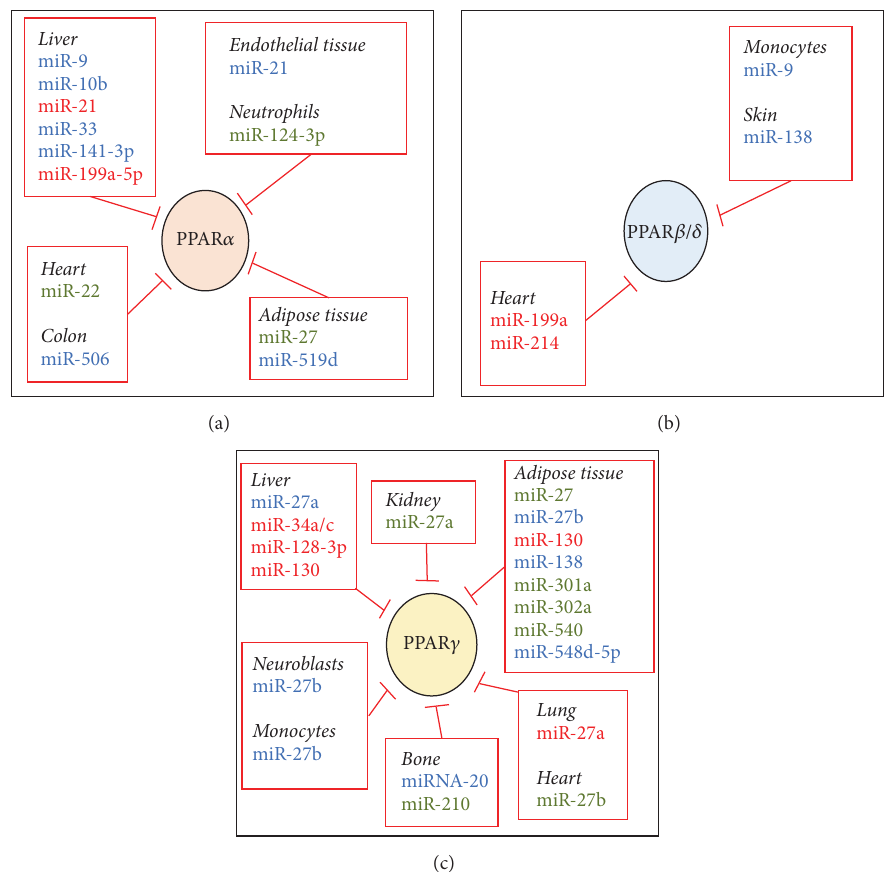
Figure 2: miRNAs targeting PPAR isoforms in specific tissues. miRNAs (also referred to in Table 1) that have been experimentally demonstrated to specifically target PPAR 𝛼 (Panel (a)), PPAR 𝛽 / 𝛿 (Panel (b)), and PPAR 𝛾 (Panel (c)) in different tissues are illustrated. miRNAs identified in human studies are in blue, those identified in mouse/rat studies are in green, and those identified in both human and rodents studies are in